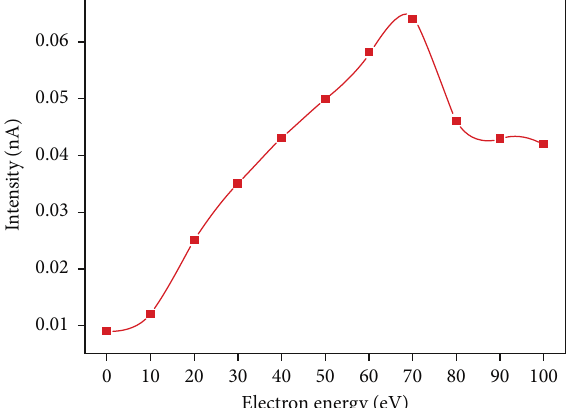
Figure 5: Function of electron intensity with the electron energy emitted from the filament.